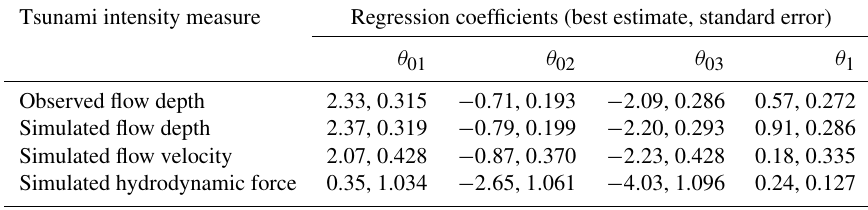
Table E2. Regression coefficients for the 2018 Sulawesi–Palu tsunami fragility curves based on DB_Palu2018.